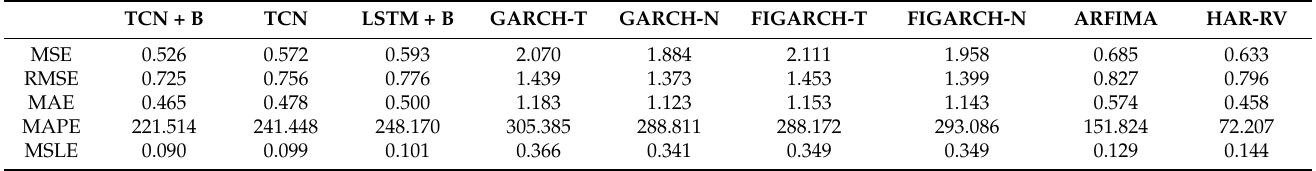
Table 10. Prediction error of each model (step size is